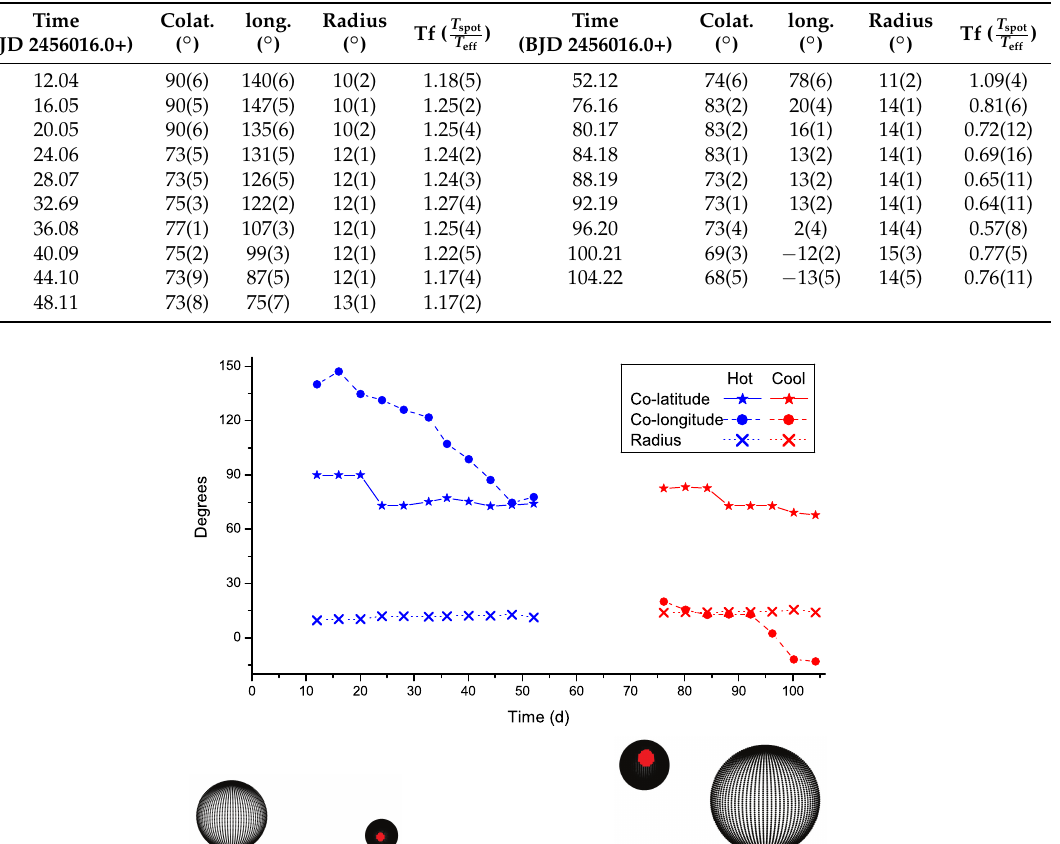
Table A1. Spot parameters for KIC 8504570.